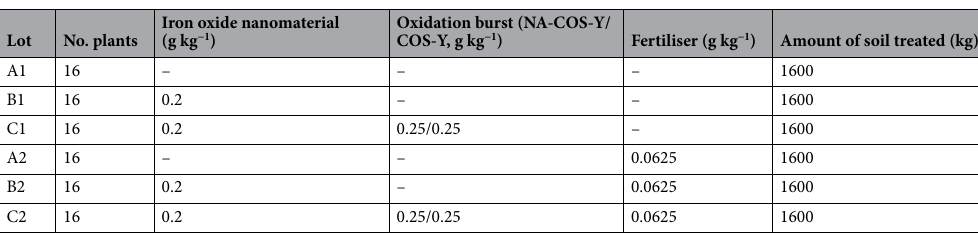
Table 2. Treatment conditions. – indicates no chemical